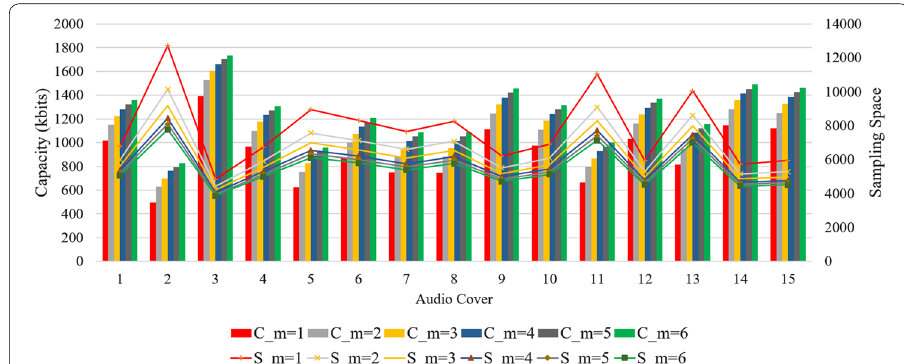
Fig. 7 The average of the maximum number of bits that can be held by the audio cover along with its average of sampling space. Here, C _ m and S _ m represent respectively the capacity and the number of sampling space with multiplier m , where m ∈ { 1,2,3,4,5,6 } , e = 3 and h =